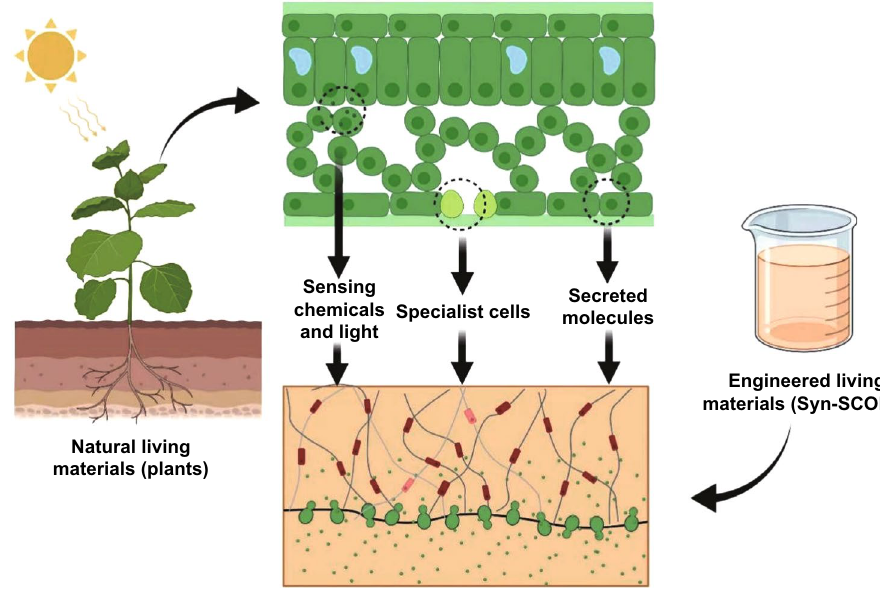
Fig. 13 Schematic diagram of analogies between natural living materials (plants) and Syn-SCOBY materials for engineered